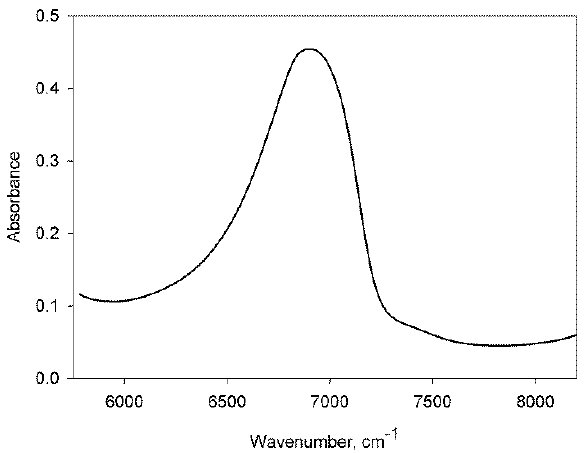
Figure 2. Representative band of 2 ν max in the near infrared (NIR) spectrum of water solutions of the Intact lactose sample. Table 2. Results of FTIR spectroscopy: the position of the maximum of the absorption band of the first overtone of intramolecular stretching vibrations of water molecules 2 ν max in the NIR spectra of aqueous solutions of the analyzed lactose samples 1 .